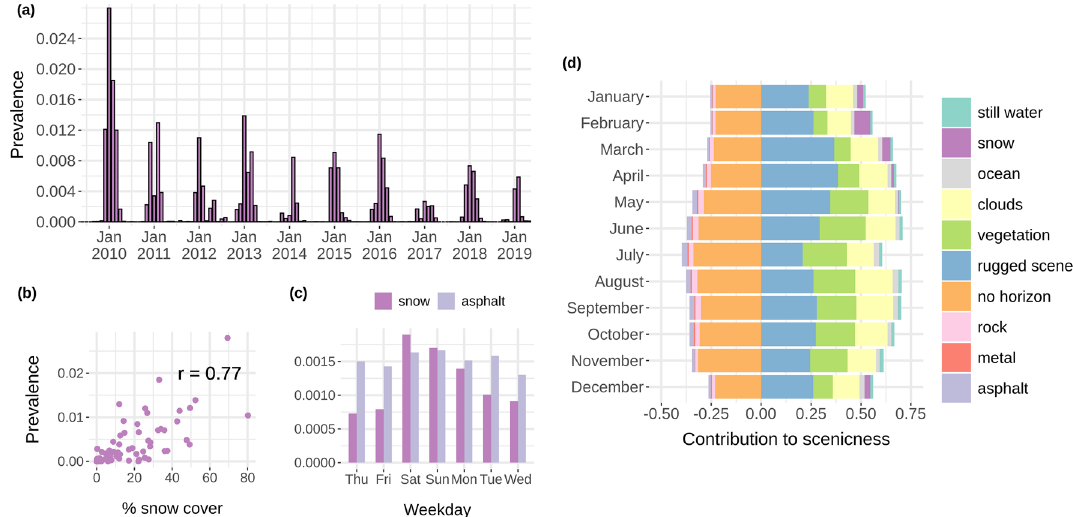
Figure 5. The influence of “snow” and other image attributes on aesthetic enjoyment over time. The ( a ) average monthly prevalence of “snow” attribute scores > 0.5 are shown between 2009 and 2019. The average monthly scores show a strong correlation (Pearson’s R = 0.77 ) with ( b ) remotely-sensed snow cover data. The ( c ) average prevalence per weekday of “snow” versus “asphalt” is also shown. A constrained linear model ( R trained using the scores > 0.5 of a selected group of attributes including “snow” to ( d ) predict scenicness at the image-level. The changing monthly contributions of some of these attributes can be observed, with “snow” contributing in the winter months. Contributions represent individual image attribute scores multiplied by the model coefficients and averaged on a monthly basis. Drawn using R 3.6.3 (https:// www.r- proje ct. org/) with the ggplot2 3.3.5 (https:// ggplo t2. tidyv erse. org) and cowplot 1.1.0 (https:// cran.r- proje ct. org/ packa ge= cowpl ot)